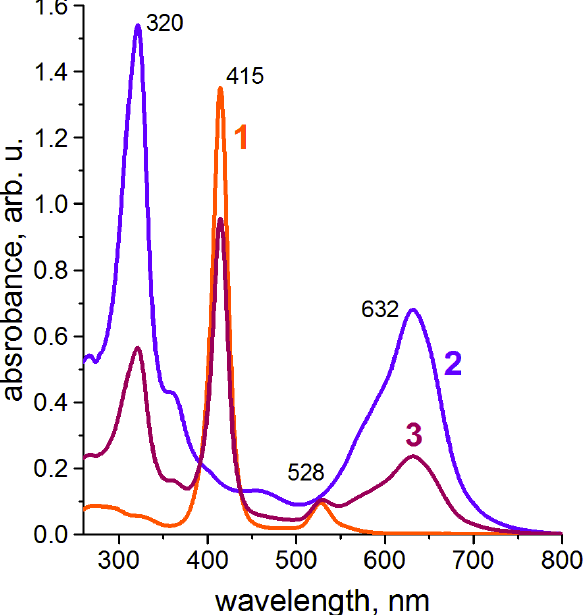
Figure 4. UV-vis spectra of (1) 5.1 × 10 − 6 M NiTPP , (2) 1 × 10 − 5 M CRPcRu(pyz) 2 solutions in chloroform, and an UV-vis spectrum of (3) the mixed solution of both in 1:1 molar ratio (concentration of each component is 3.4 × 10 − 6 M).